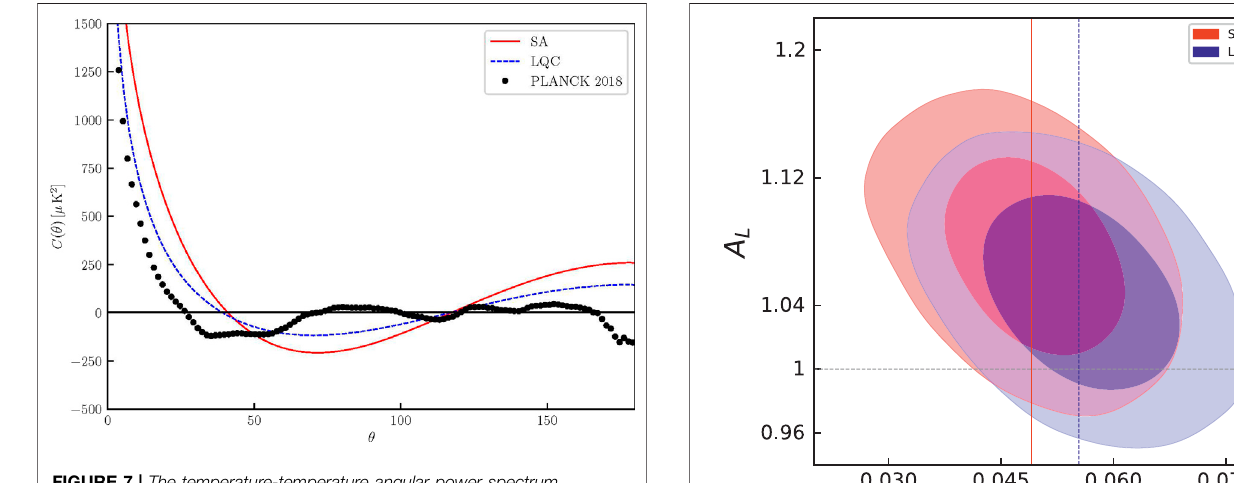
FIGURE 7 | The temperature-temperature angular power spectrum C ( θ ) . The 2018 PLANCK spectrum (thick black dots), the LQC [dashed (blue) line], and the standard ansatz [solid (red) line] predictions. The LQC predictions are closer to the observed Planck 2018 data points. FIGURE 8 | 1 σ and 2 σ probability distributions in the A